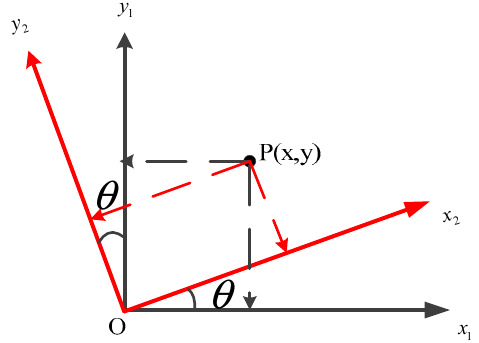
Figure 12. Derivation of affine transformation. In the coordinate system, the counterclockwise rotation of P is equivalent to the clockwise rotation of the coordinate system.